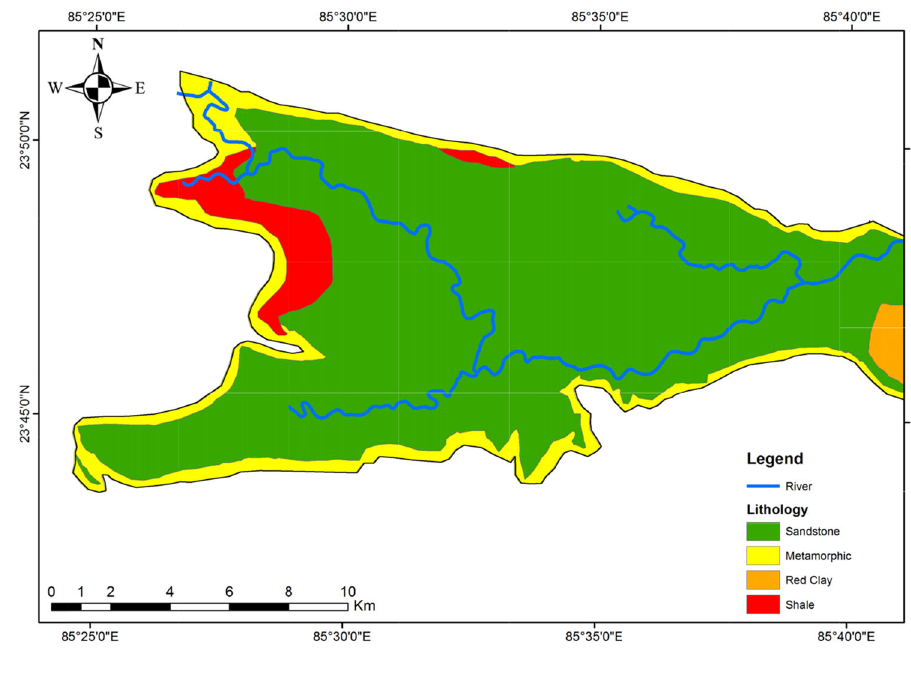
Fig. 8 Landuse class map